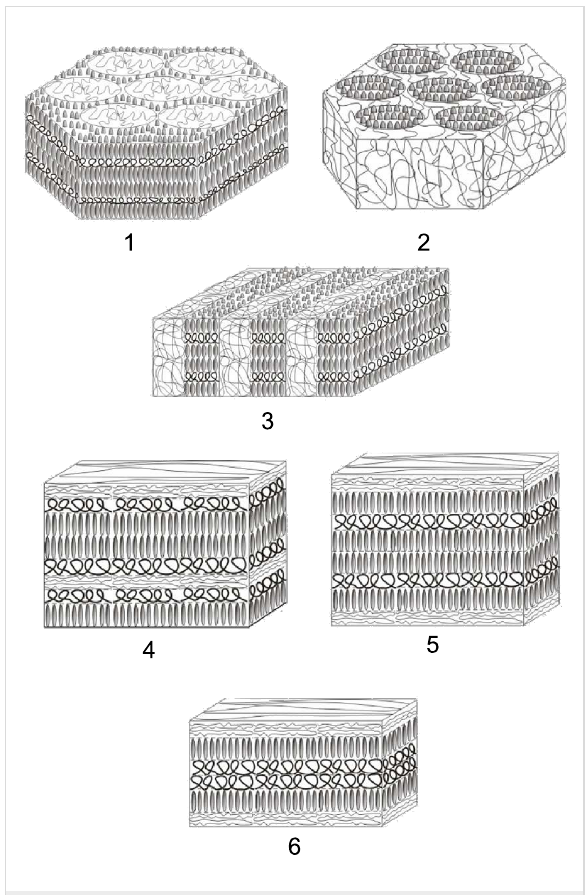
Figure 3: Stable morphologies in coil–LC comb copolymer